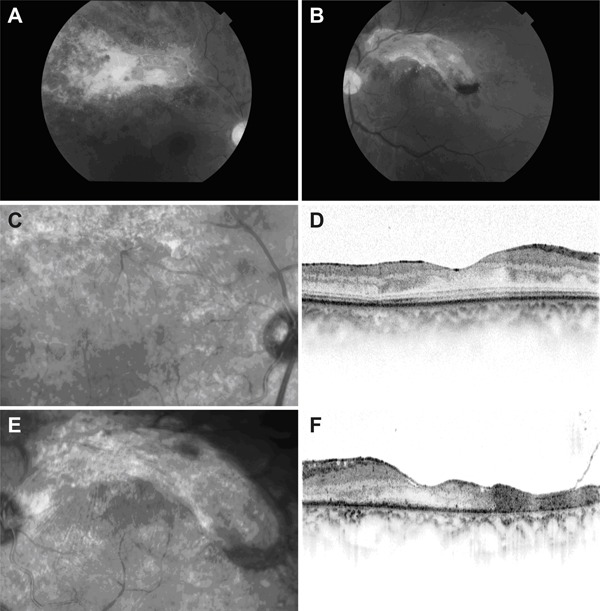
Bilateral cytomegalovirus retinitis of the patient with AIDS.
A, Retinitis in the process of cicatrization with hemorrhage
in the superior temporal arcade of the right eye. B,
Cicatrization of human cytomegalovirus retinitis of the left eye involving the
superior temporal arcade and parts of the posterior pole and the macula.
C, Detailed image of retinitis of the right eye.
D, Tomography of the macular region of the right eye
demonstrating its preserved thickness. E, Detailed image of
retinitis of the left eye. F, Thinning and disorganization of the
macular zone layers of the left eye, tomography.